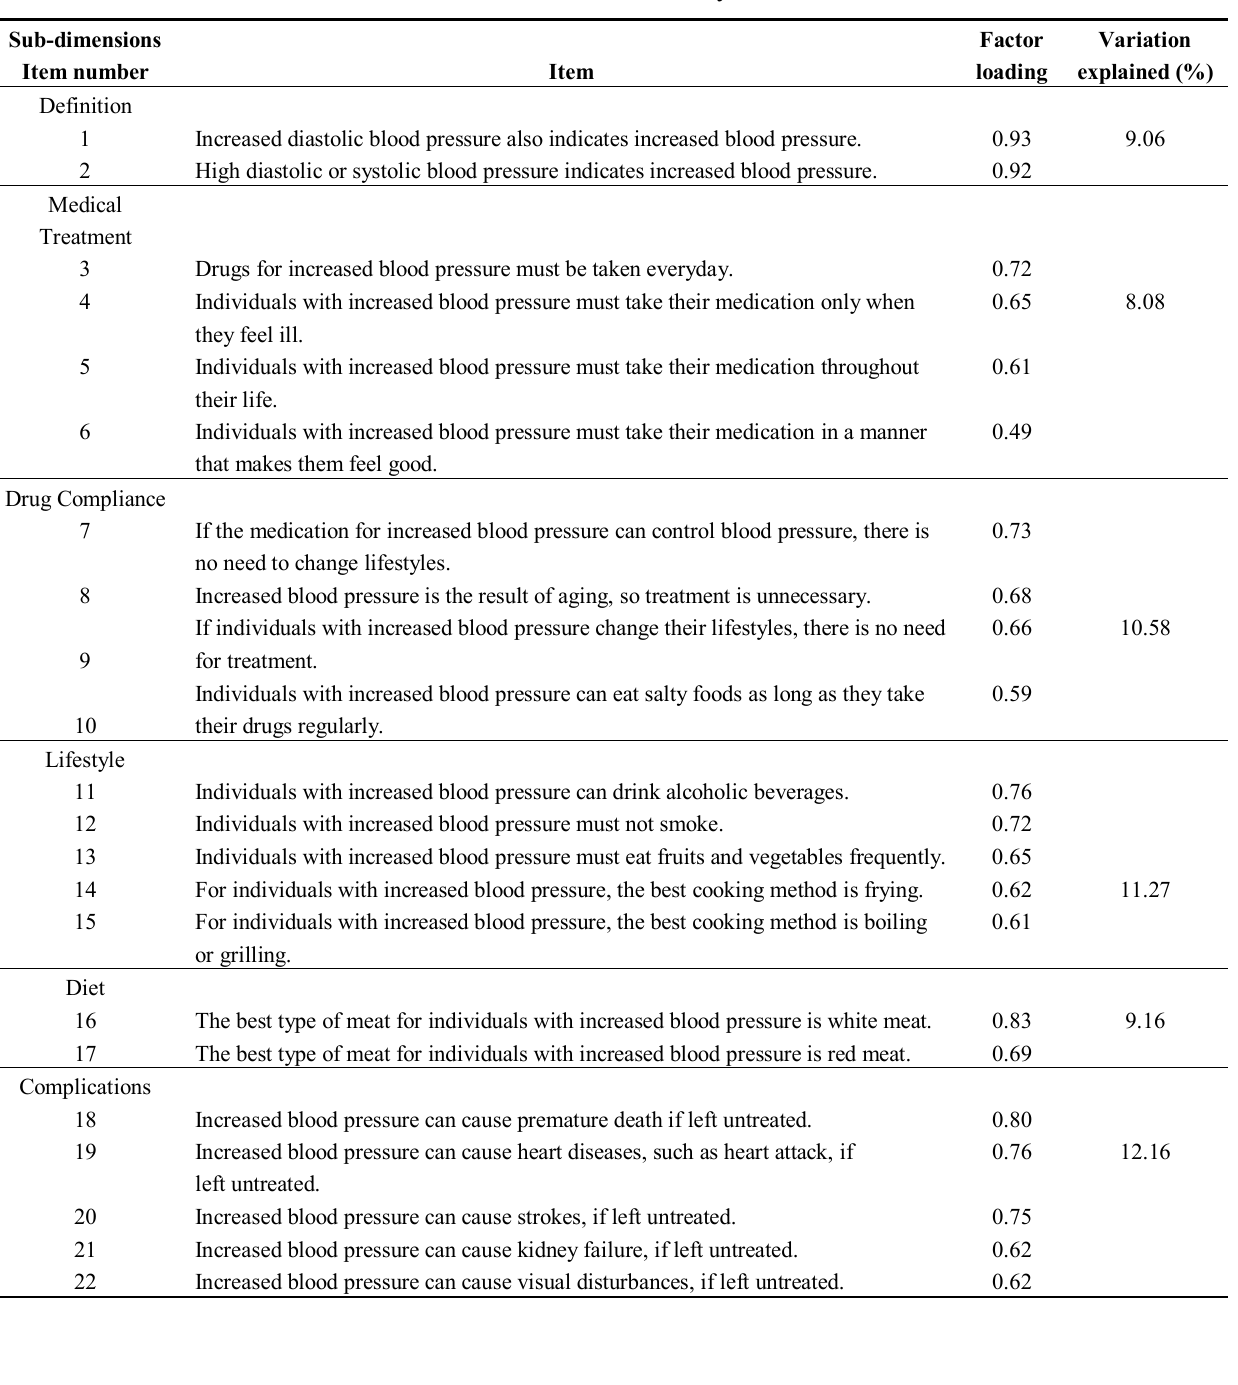
Table 2. Results of the factor analysis for HK-LS